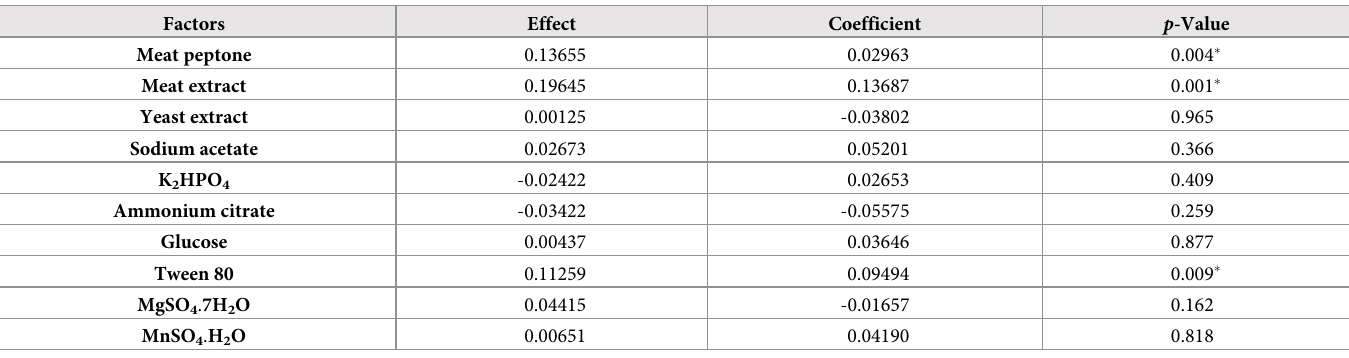
Table 2. Predicted effects of the factors on the growth of L . reuteri CRL1098.